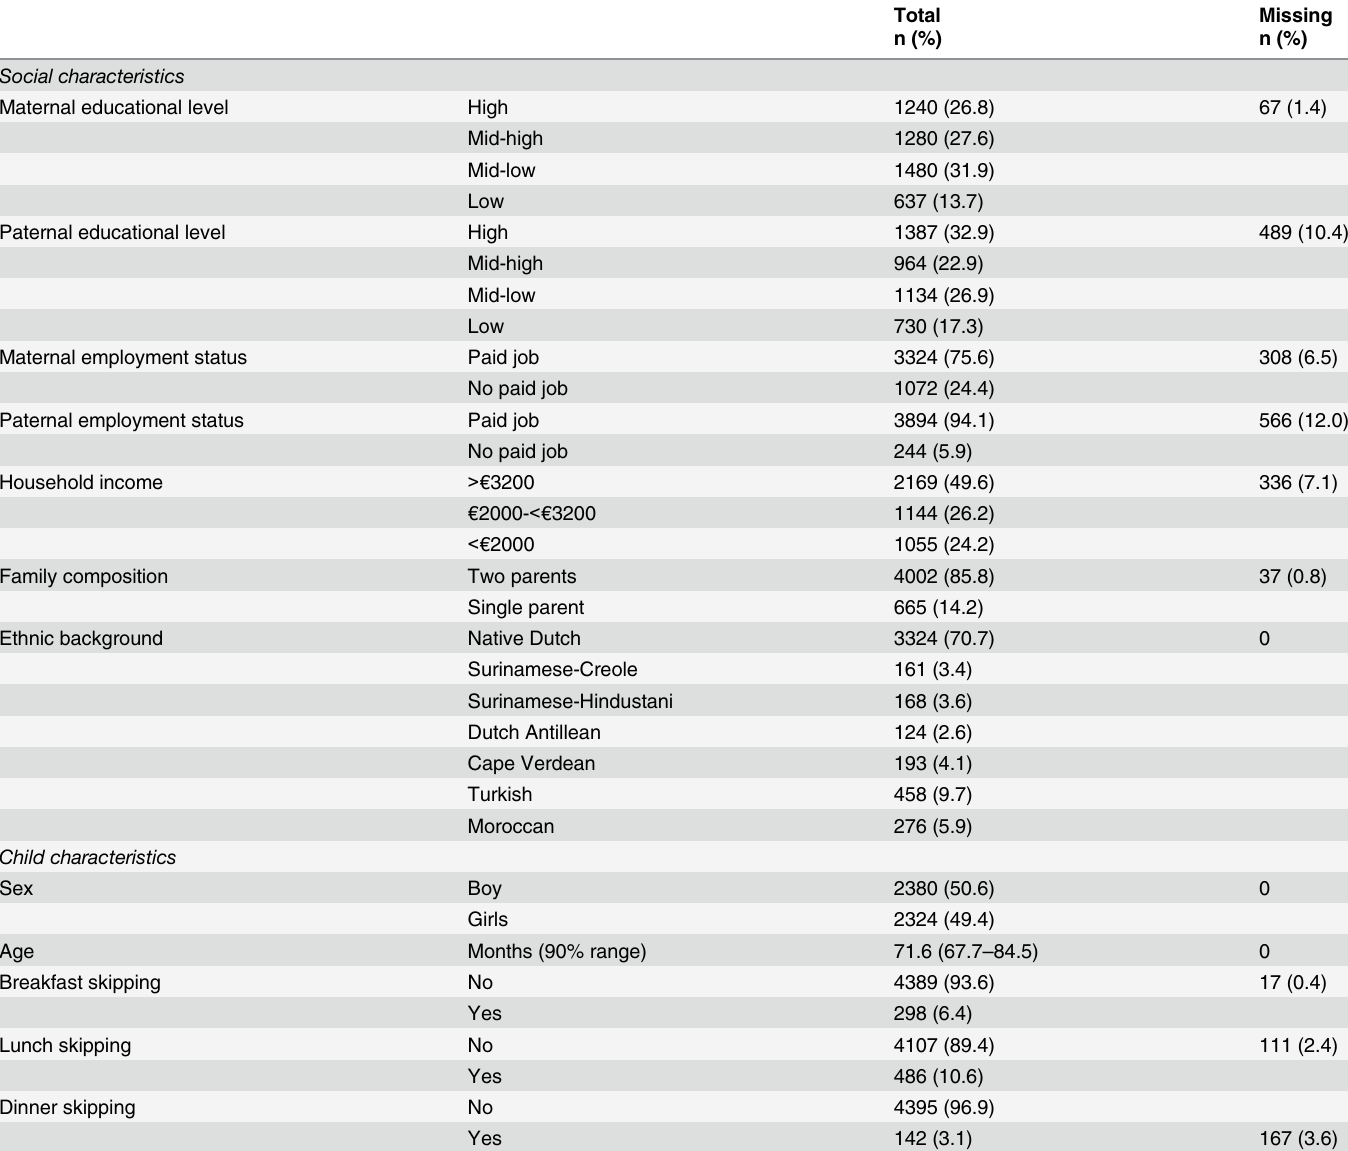
Table 1. Characteristics of the study population (n = 4704).